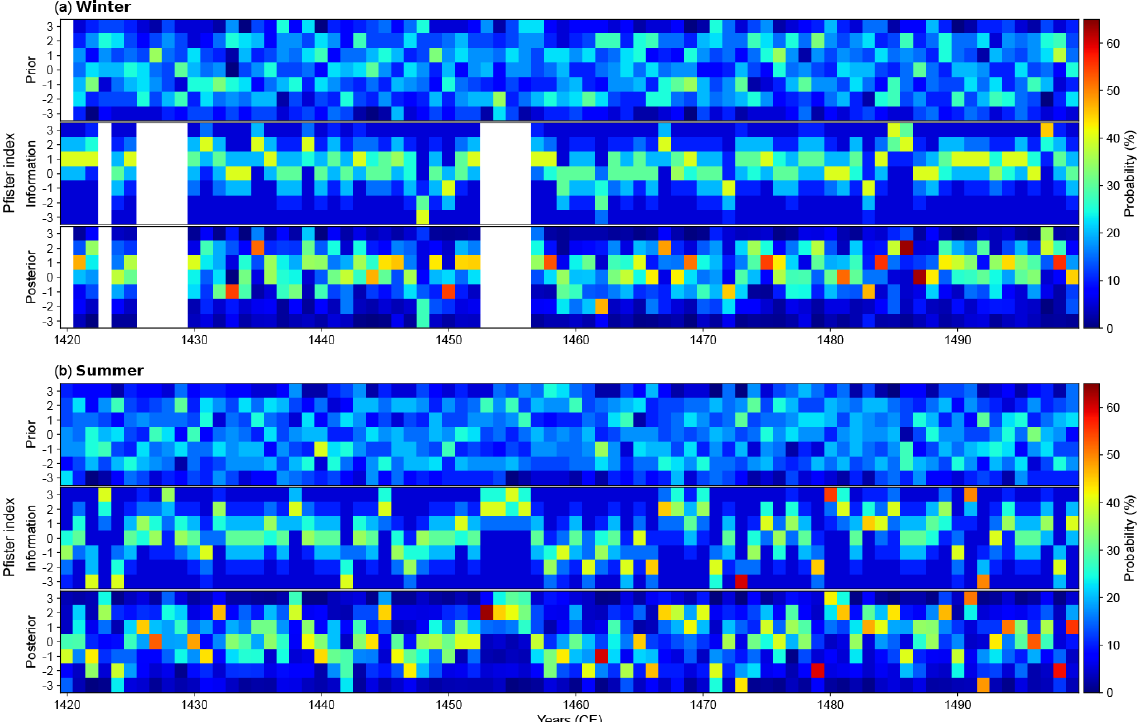
Figure 5. Prior, historical information, and posterior probability distributions of seasonal wet days in a month in the Burgundian Low Countries for (a) winters and (b) summers ranging from 1420 to 1499CE. Top panels represent the prior probability distribution, p (climate), extracted from the 40-member ModE-Sim ensemble and converted into Pfister indices. Middle panels illustrate the probability distribution of the precipitation information, p (observations | climate) /p (observations), acquired from historical archives compiled and converted into Pfister indices by historians. Bottom panels depict the posterior probability distribution, p (climate | observation). White spaces are shown when there are no observations available and therefore the posterior matches the prior.